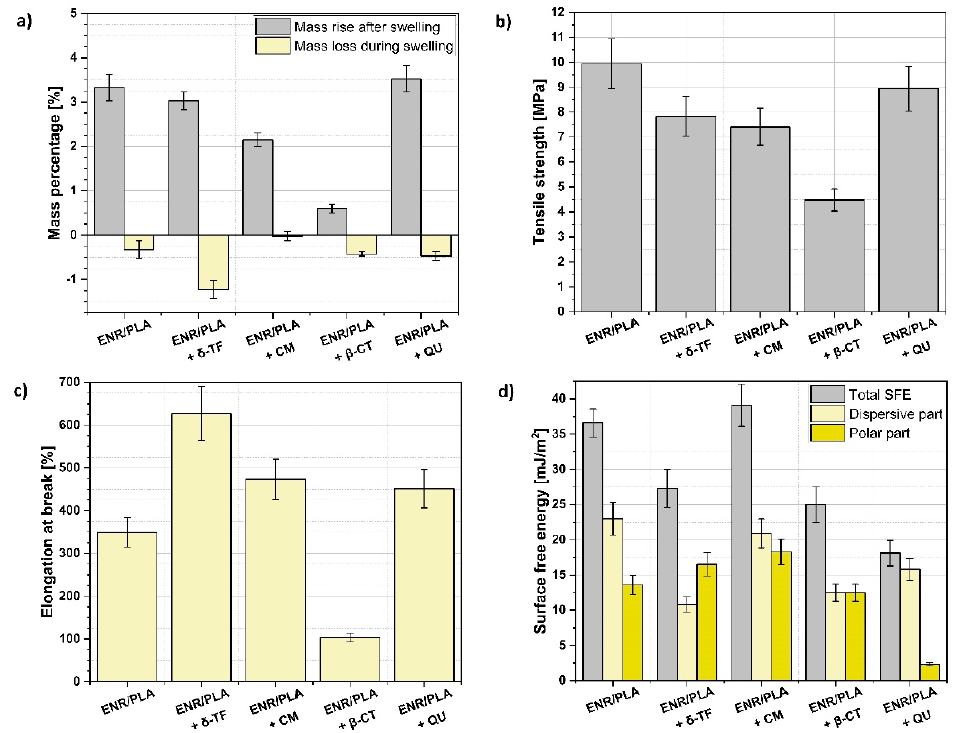
Figure 2. ENR/PLA blend properties before the accelerated aging processes: ( a ) analysis of the swelling experiment, ( b ) tensile strength of analyzed specimens, ( c ) elongation at break of investi- gated samples, ( d ) surface free energy and its components analysis.